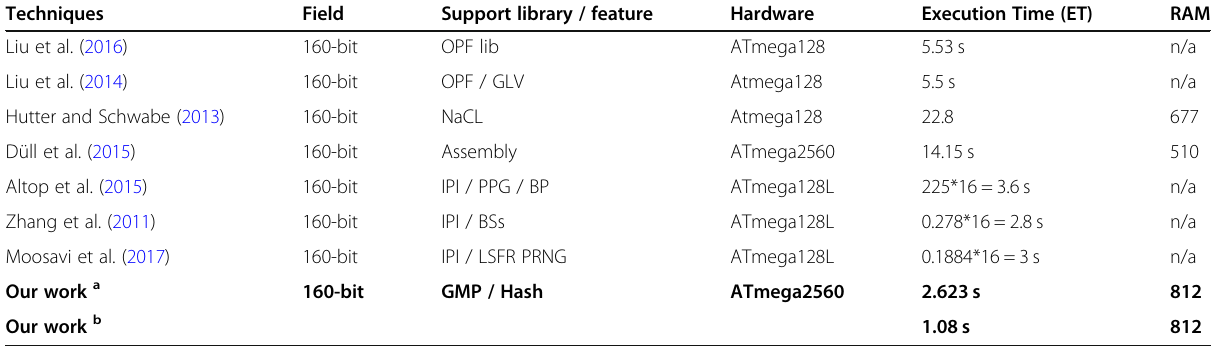
Table 7 Encryption cost comparison with existing technique in AVR hardware Techniques